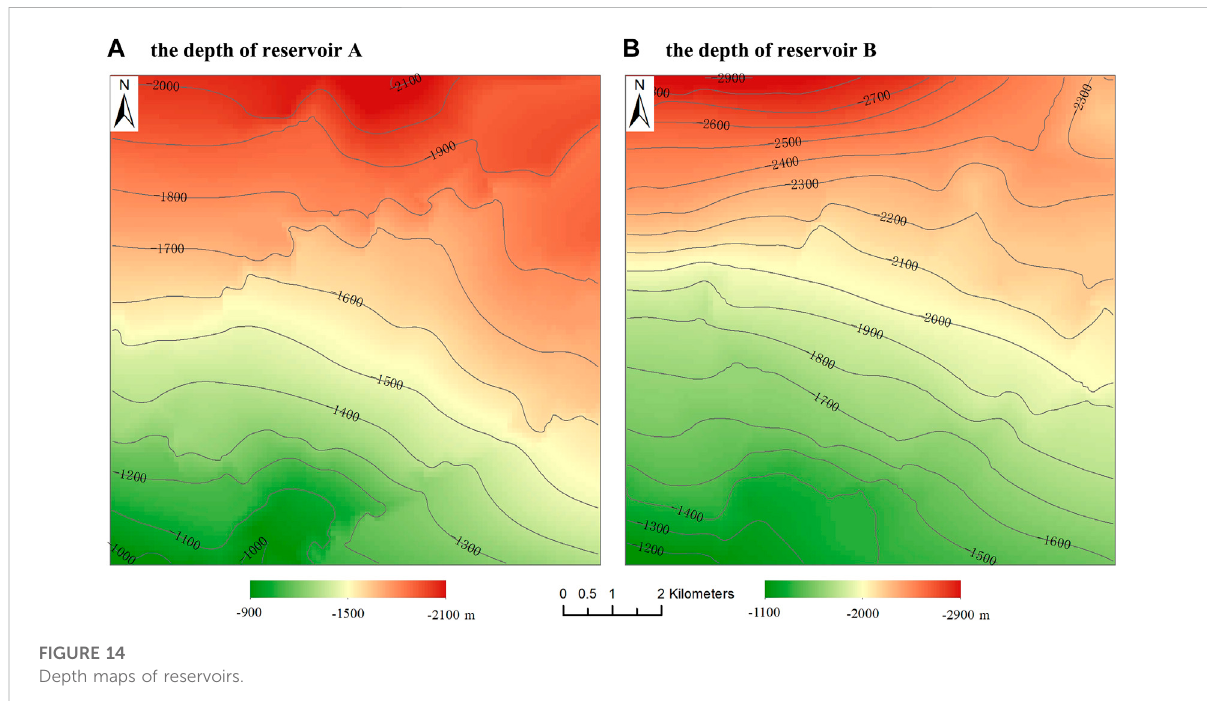
FIGURE 14 Depth maps of